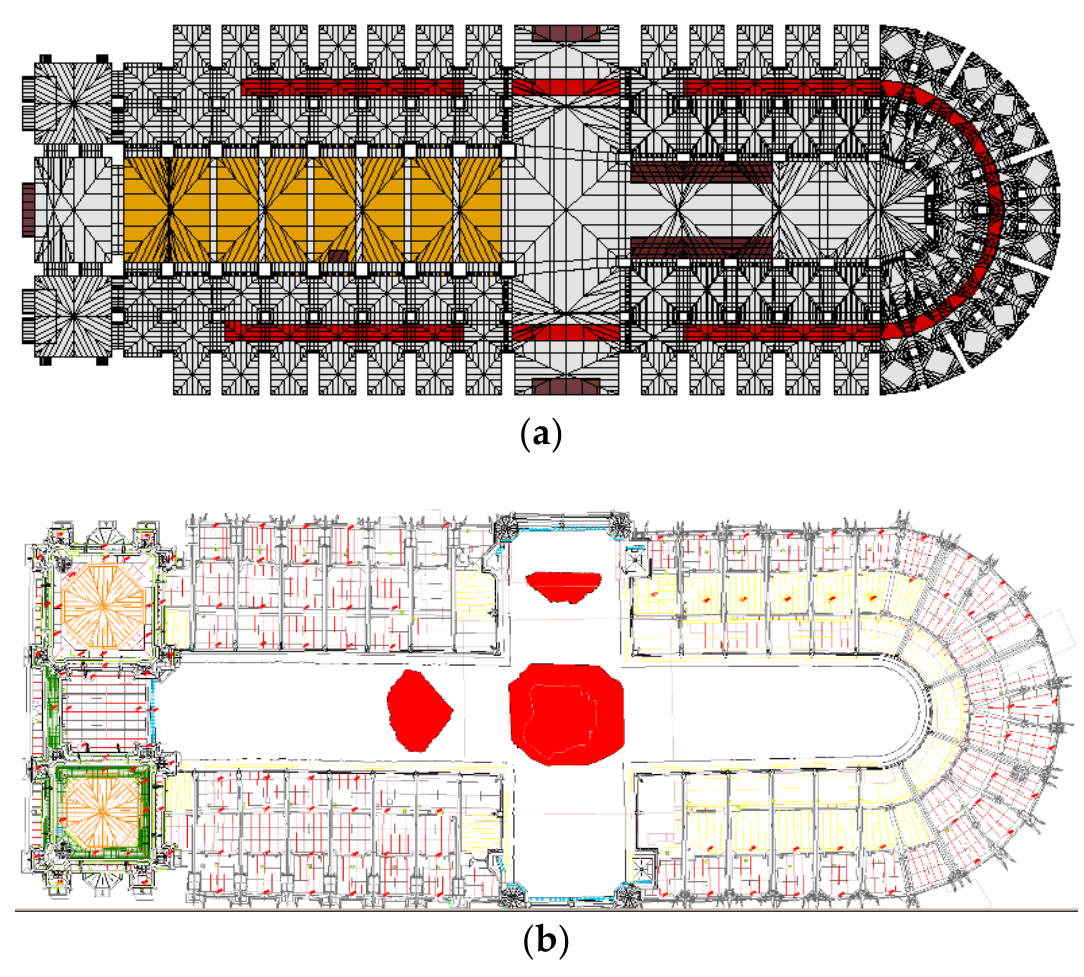
Figure 3. Schematics of the Cathédrale Notre-Dame de Paris highlighting specific surfaces. ( a ) Computer model highlighting pew locations (yellow) and carpet runner addition (red); ( b ) Architectural plans indicating the principal holes (red) in the vaulted ceiling (2020).